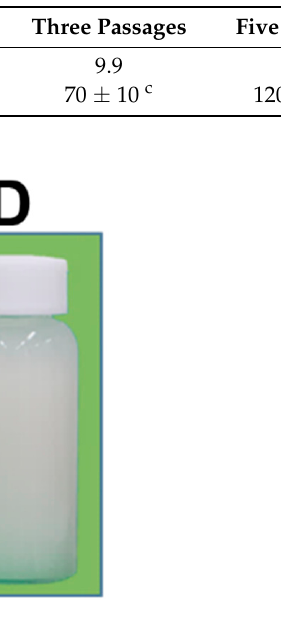
Figure 1. Wet-type grinder (WG)-treated okara in water after 24 h. Okara (2 wt%) was treated with the WG for different passages. ( A ) untreated; ( B ) one passage; ( C ) three passages; ( D ) five pas- sages.